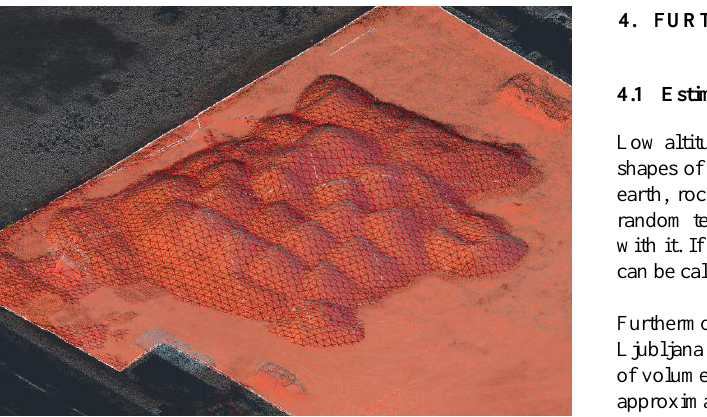
Figure 4. Comparison of DTMs for volume of asphalt pile assessment